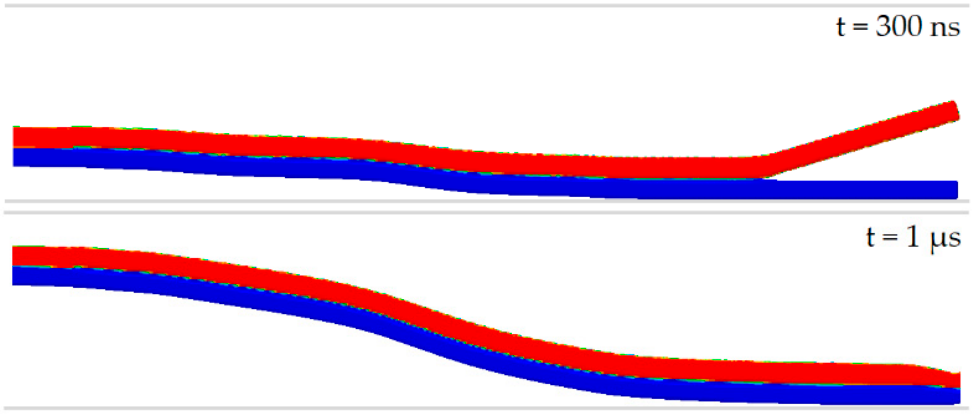
Figure 18. Eulerian volume fraction (EVF) of the aluminum foil in angled and curved LIW orientations at different times in Eulerian simulations assuming an initial flyer shape and constant velocity.